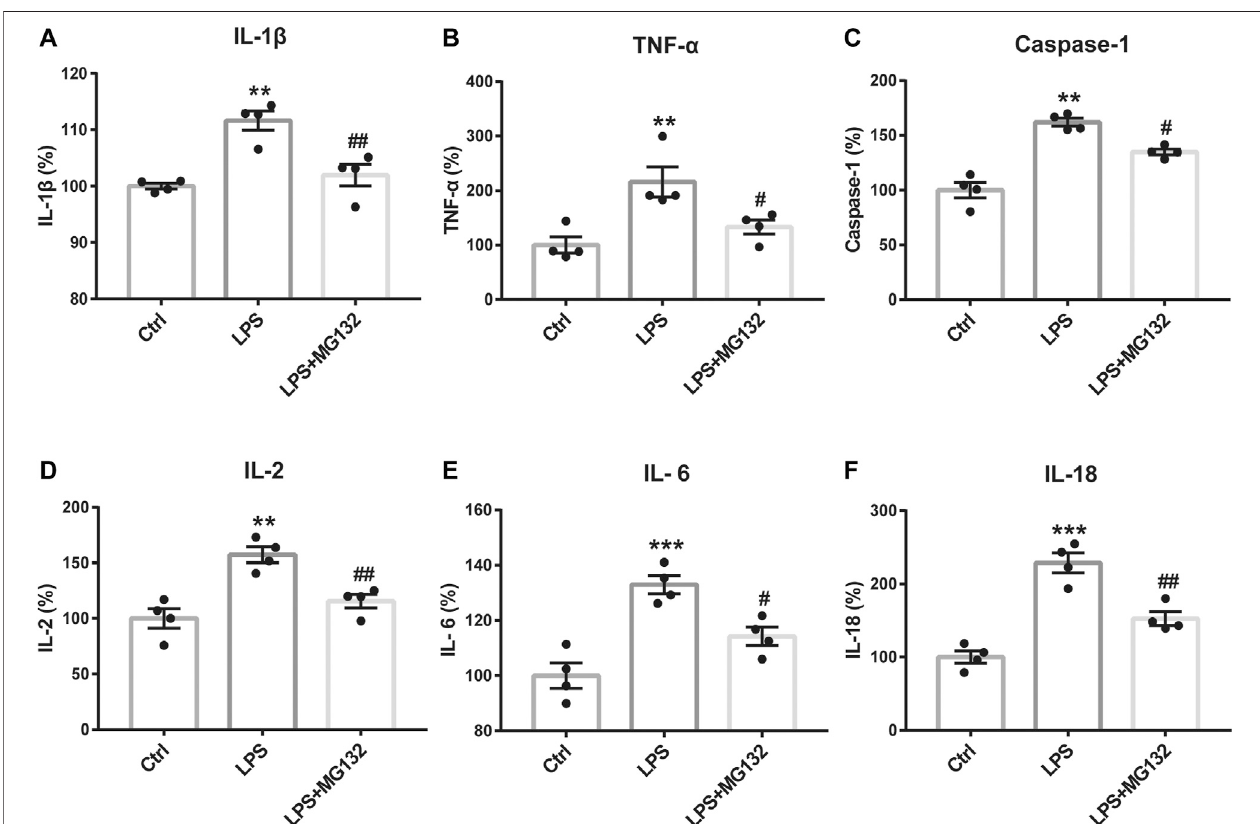
FIGURE 10 | The anti-in fl ammatory effect of Rg1 may exert by the inhibition of ubiquitination. Inhibiting the ubiquitin-proteasome degradation by MG132 could reversetheincreaseofIL-1 β (A) ,TNF- α (B) ,caspase-1 (C) ,IL-2 (D) ,IL-6 (E) ,andIL-18 (F) causedbyLPSinglialcells,whichwassimilartotheanti-in fl ammatoryeffectof Rg1. n (cid:1) 4. ** p < 0.01 and *** p < 0.001, compared with the Ctrl group; ## p < 0.01 and # p < 0.05, compared with the LPS